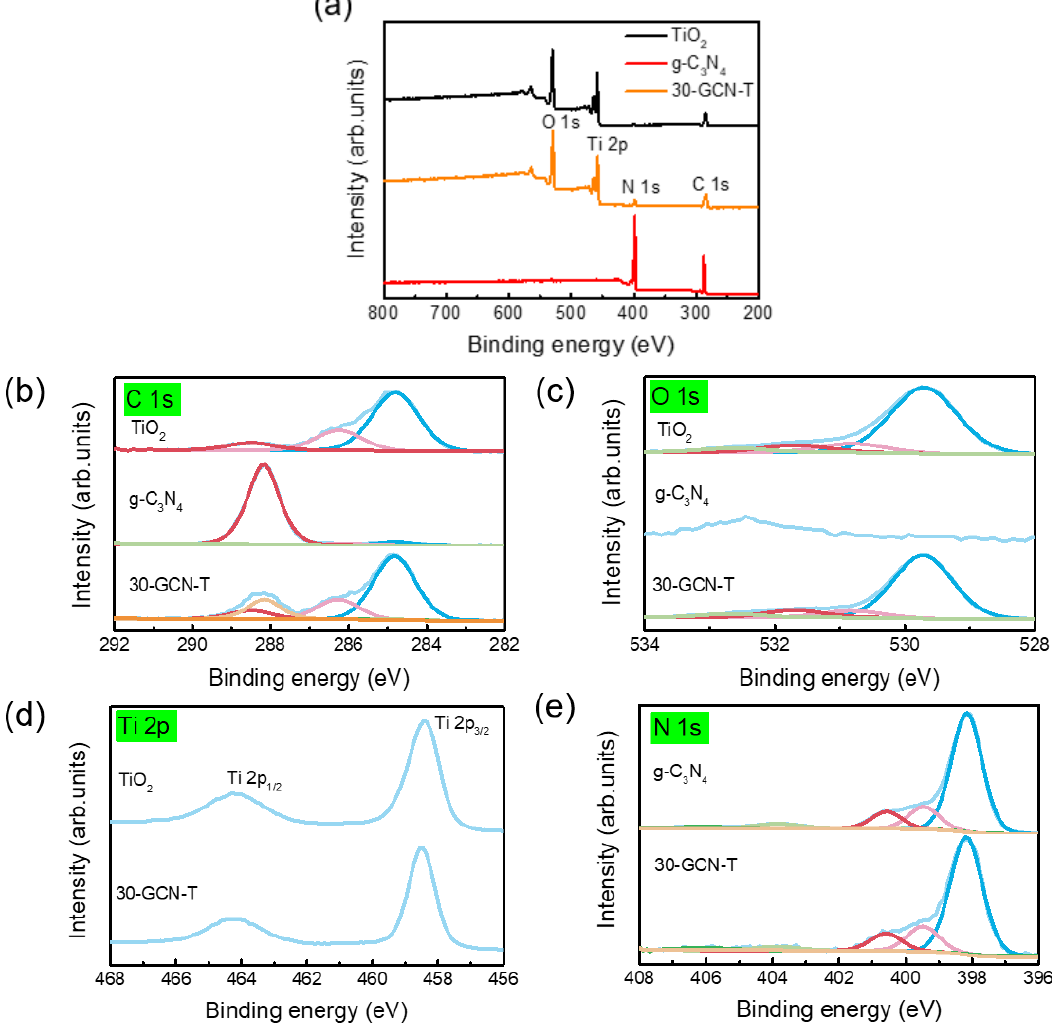
Figure 8. ( a ) XPS survey spectra of TiO 2 , g-C 3 N 4 and 30-GCN-T materials. ( b ) Deconvolution of XPS C 1s of TiO 2, g-C 3 N 4 and 30-GCN-T spectra. ( c ) Deconvolution of XPS O 1s spectra of TiO 2, g-C 3 N 4